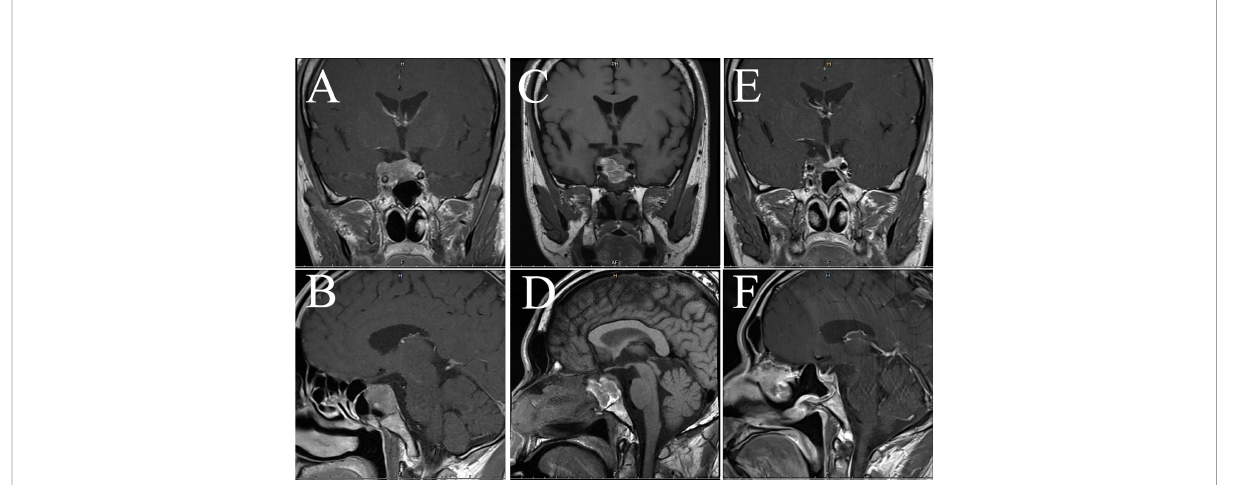
FIGURE 8 Imaging examination of case 4. The images show coronal and sagittal MRI of the patient ’ s head preoperatively (A, B) , one week postoperatively (C, D) , and three months postoperatively (E, F) ,